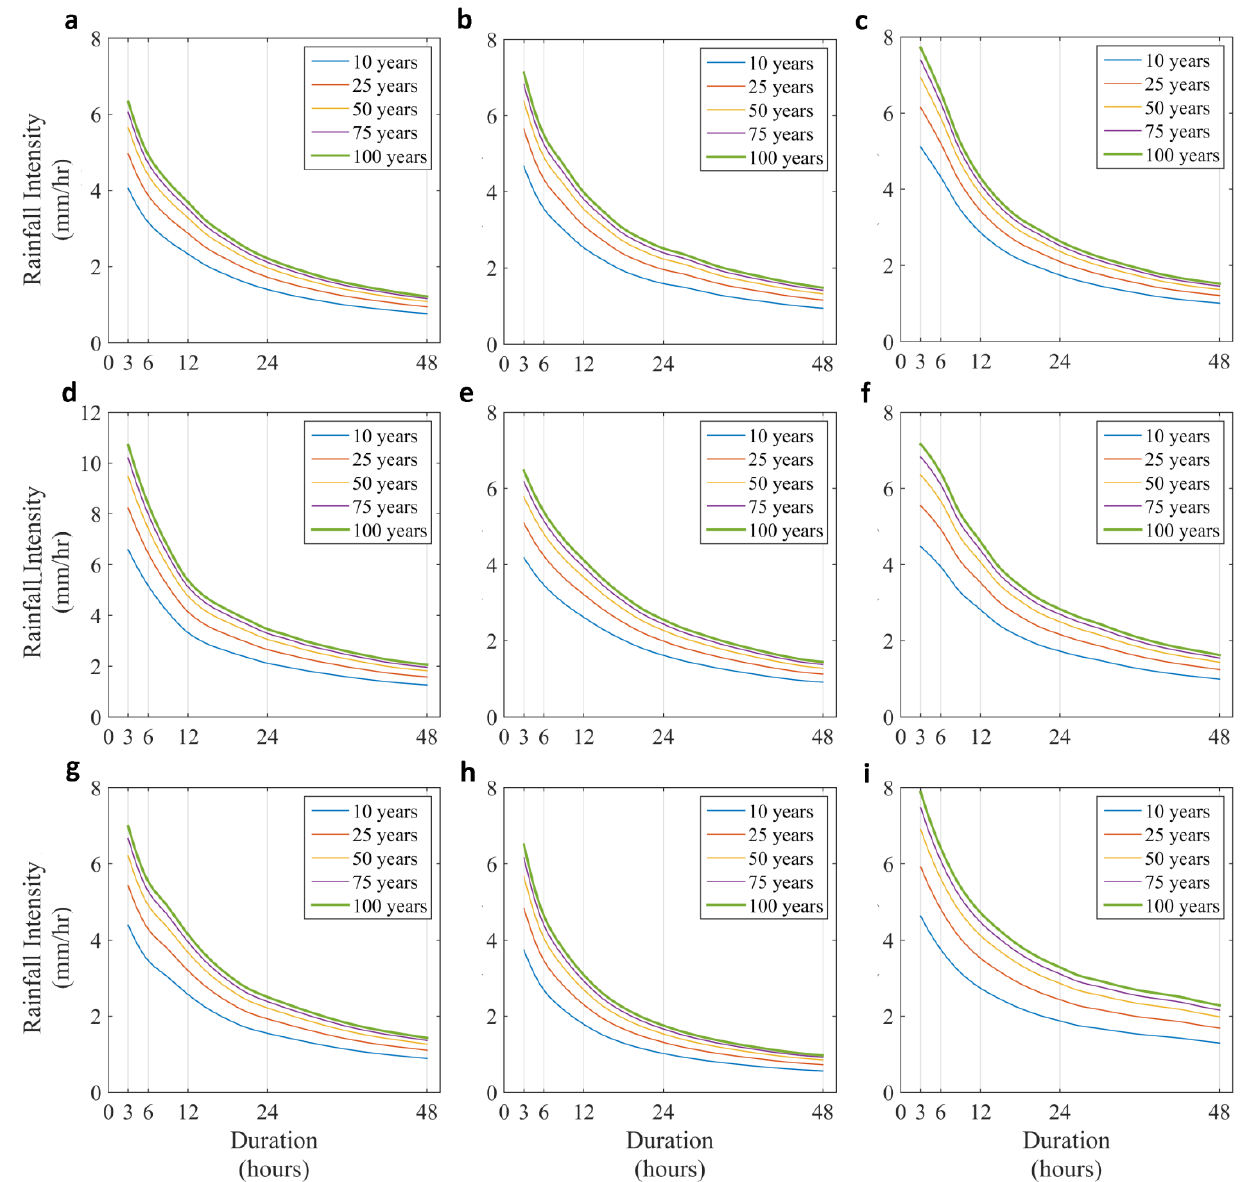
Figure 12. IDF curves (modeled output) for selected locations/cities in the east part of the Arabian Peninsula: ( a ) Kuwait city, ( b ) Burayadah, ( c ) Manama, ( d ) Riyadh, ( e ) Doha, ( f ) Dubai, ( g ) Abu Dhabi, ( h ) Muscat and (i) Salalah.